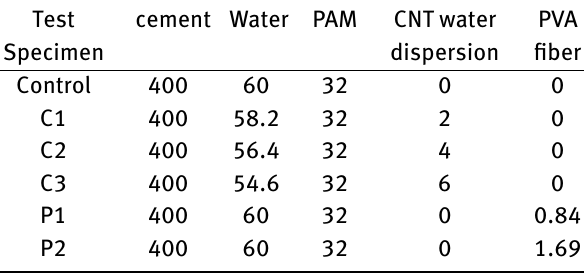
Table 4: Mix proportions of the test